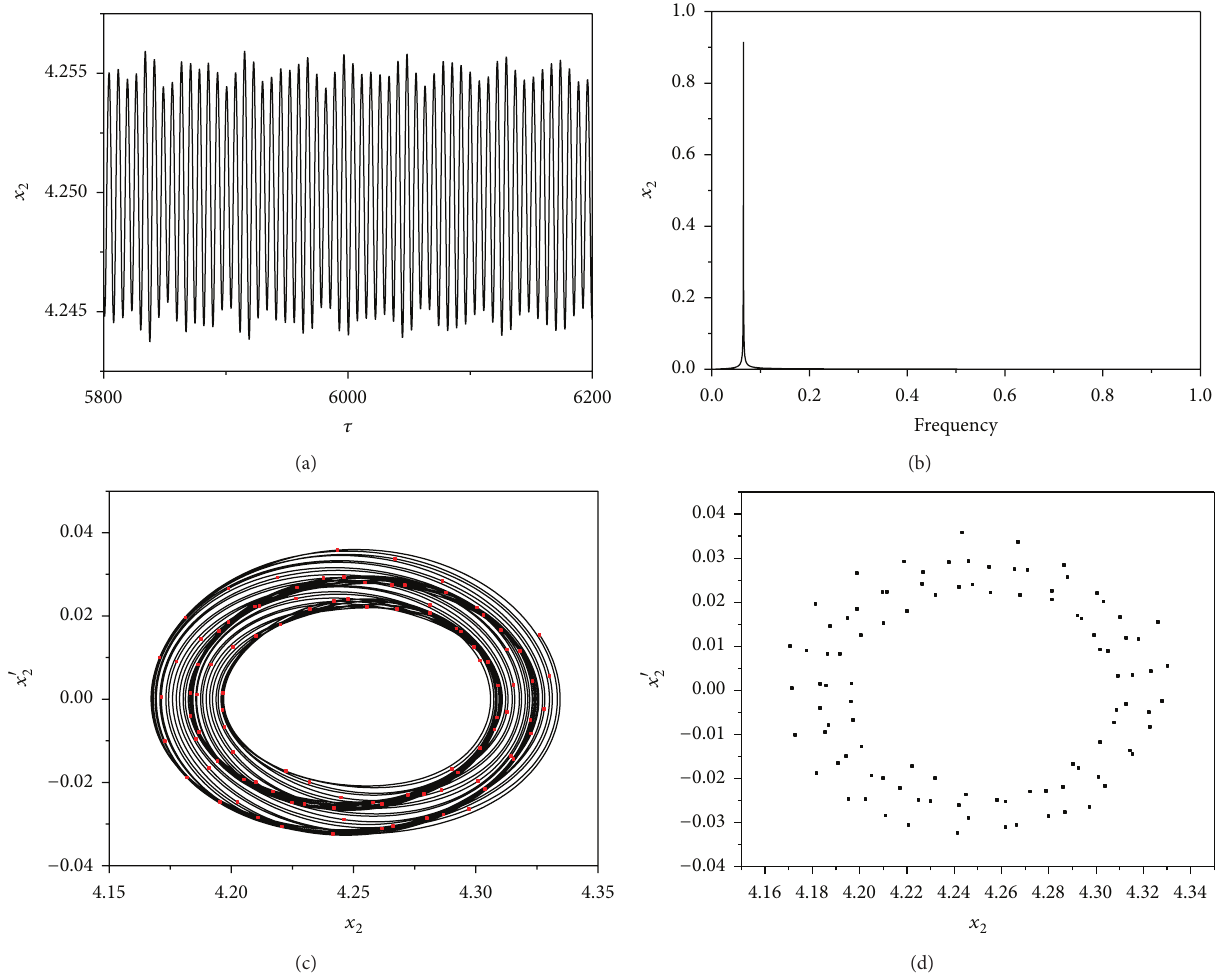
Figure 17: See 𝜔 = 1.20 . (a) Displacement response. (b) Frequency spectrum. (c) Phase-portrait plots. (d) Poincar´e maps.